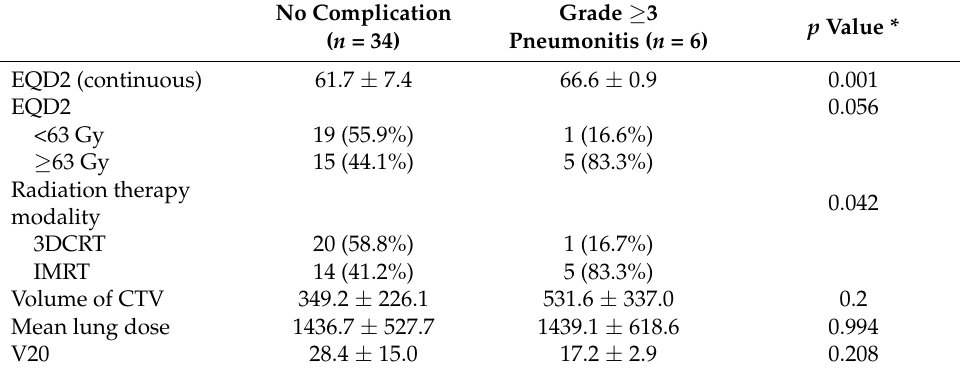
Table 5. Factors related to Grade ≥ 3